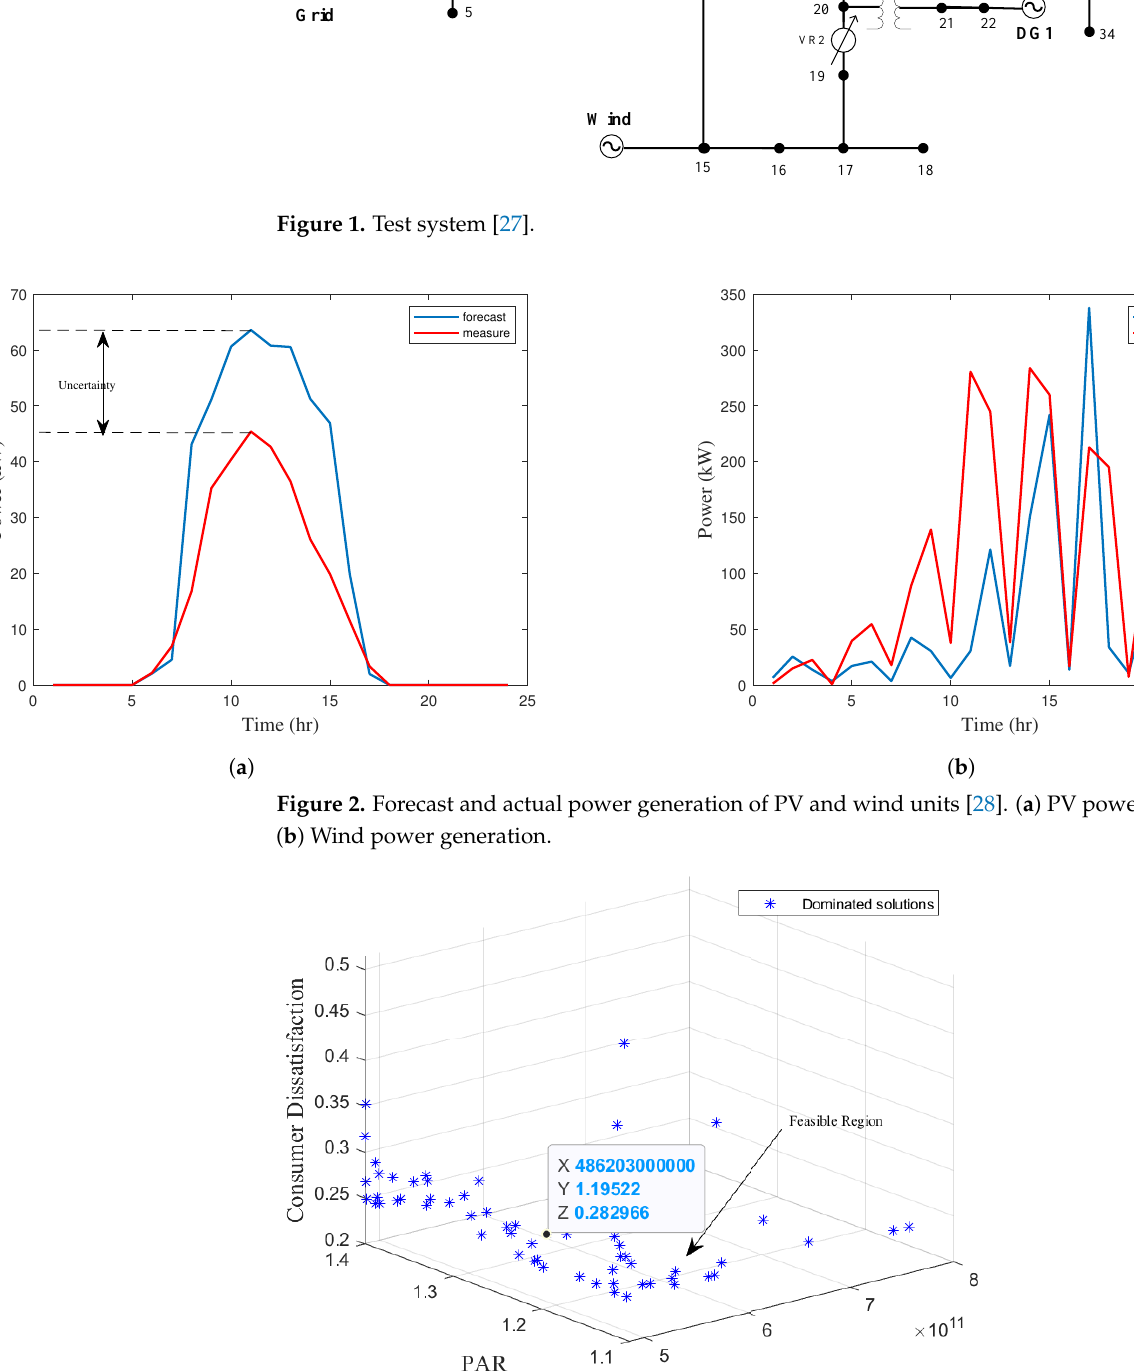
Figure 3. Pareto-optimal solutions for operation cost, PAR and consumer